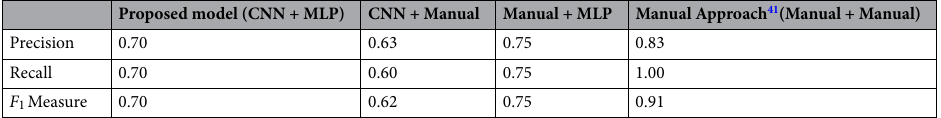
Table 3. Accuracy of the four cases for discriminating the invasiveness of cancer cells. The manual approach works based on ground truths, and it is difficult to directly compare it with the proposed methods. We present its accuracy to demonstrate the goal that we need to identify and reveal the inherent deviation of cell